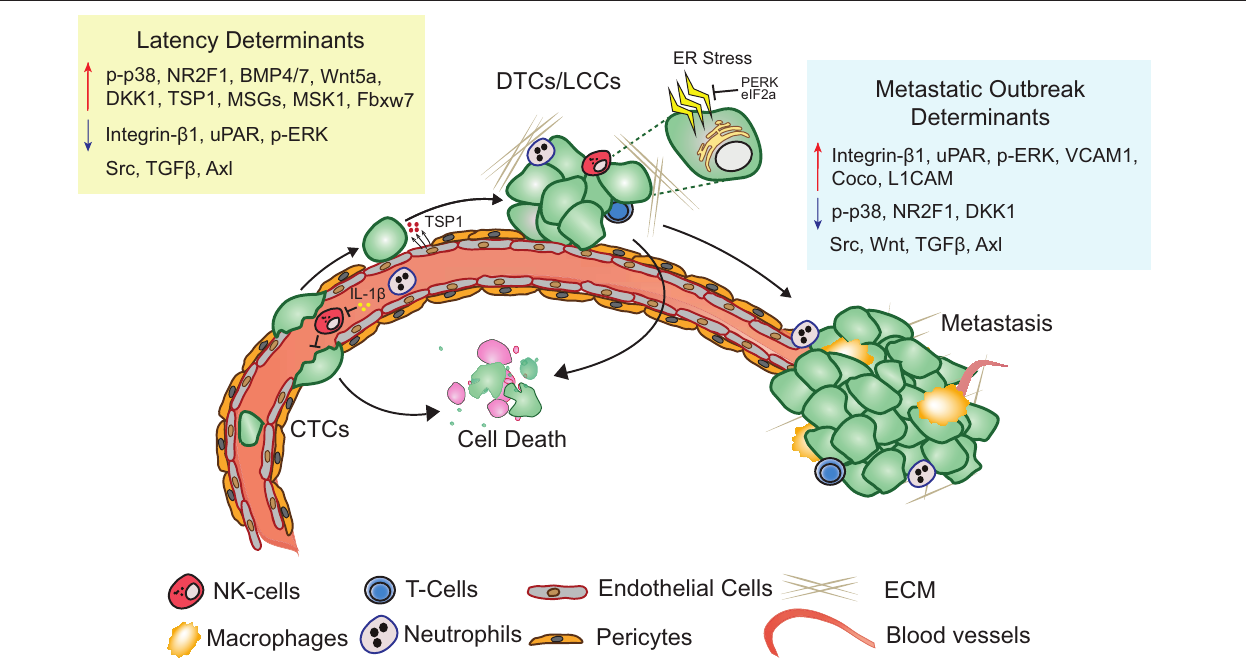
FIGURE 1 | Metastatic latency. Upon extravasation, many DTCs perish, few surviving LCCs adapt to and modify the surrounding microenvironment, eventually giving rise to metastasis. Key molecular determinants of latency and metastatic outbreak are highlighted (Refer text for more